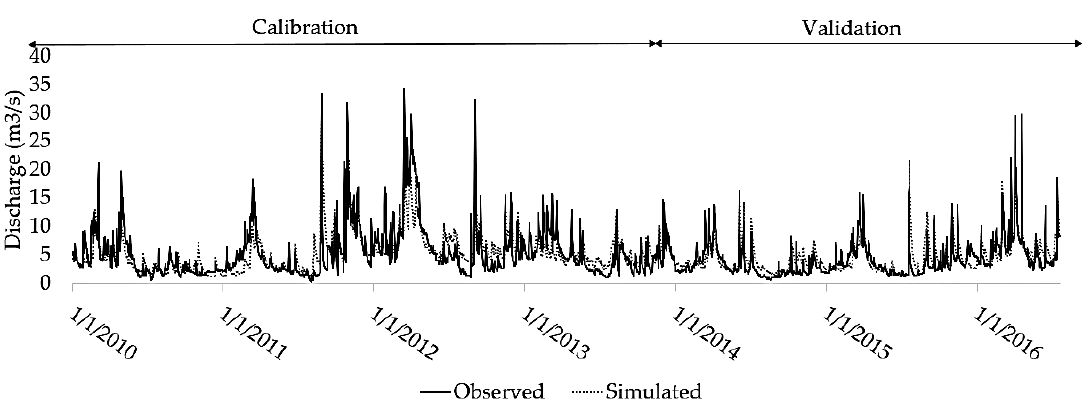
Figure 6. Comparison between observed and simulated streamflow during the calibration and validation periods.